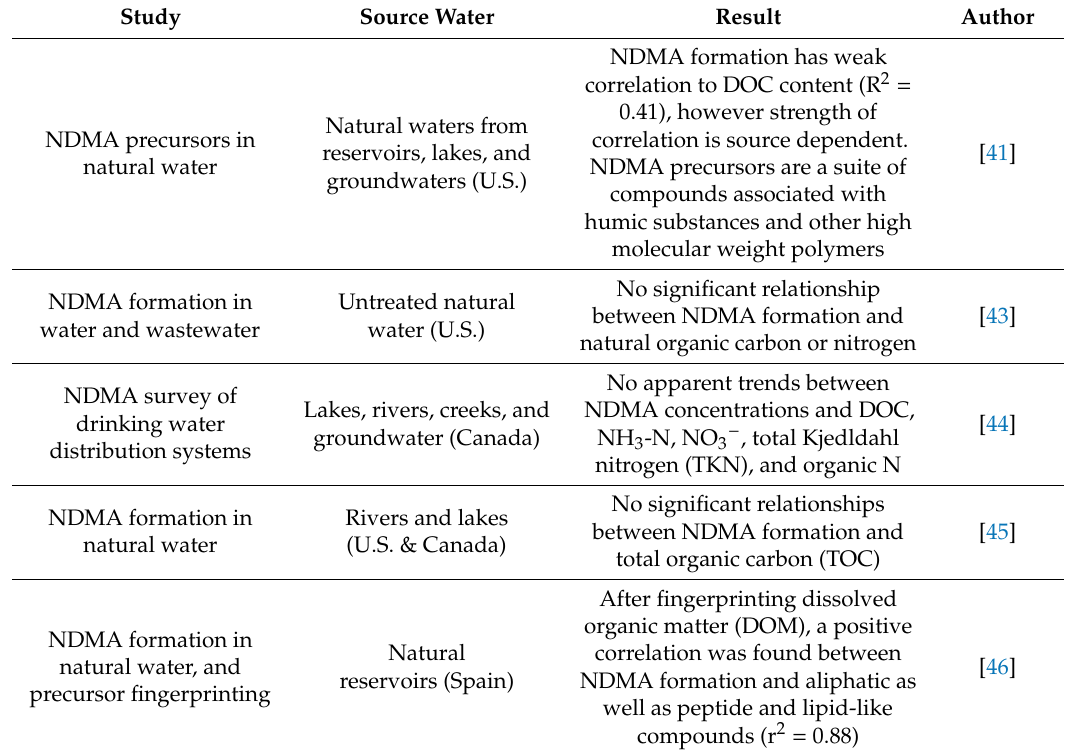
Figure 7. NDMA concentrations in product water after ( a ) 24 h monochloramine CT, and ( b ) 72 h monochloramine CT. Samples were collected at three major phases during treatment: R = untreated raw water; F = dual-media filtration effluent; GAC = dual media filtration + GAC filtration effluent. Plots based off of all NDMA concentrations regardless of seasonal sampling event. CB = Cork Brook, BB = Bailey Brook. Table 1. Study comparison on NDMA precursors and their impact on NDMA formation during water treatment.